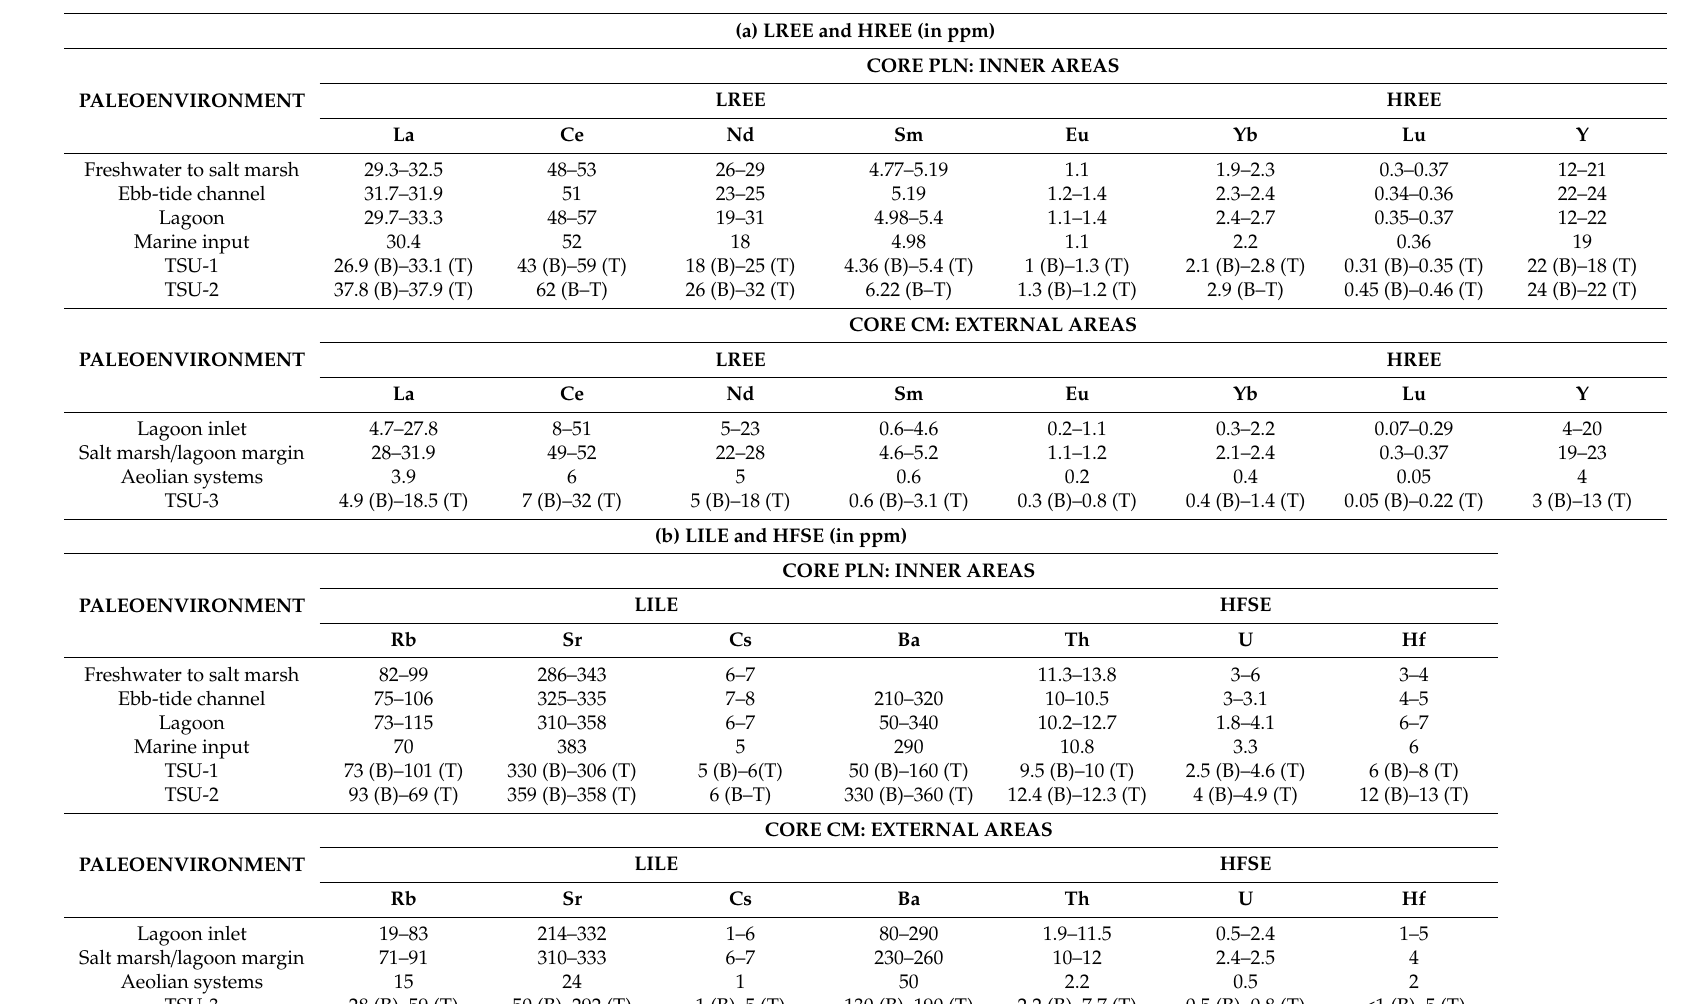
Table 3. Paleoenvironments. B: base; T: